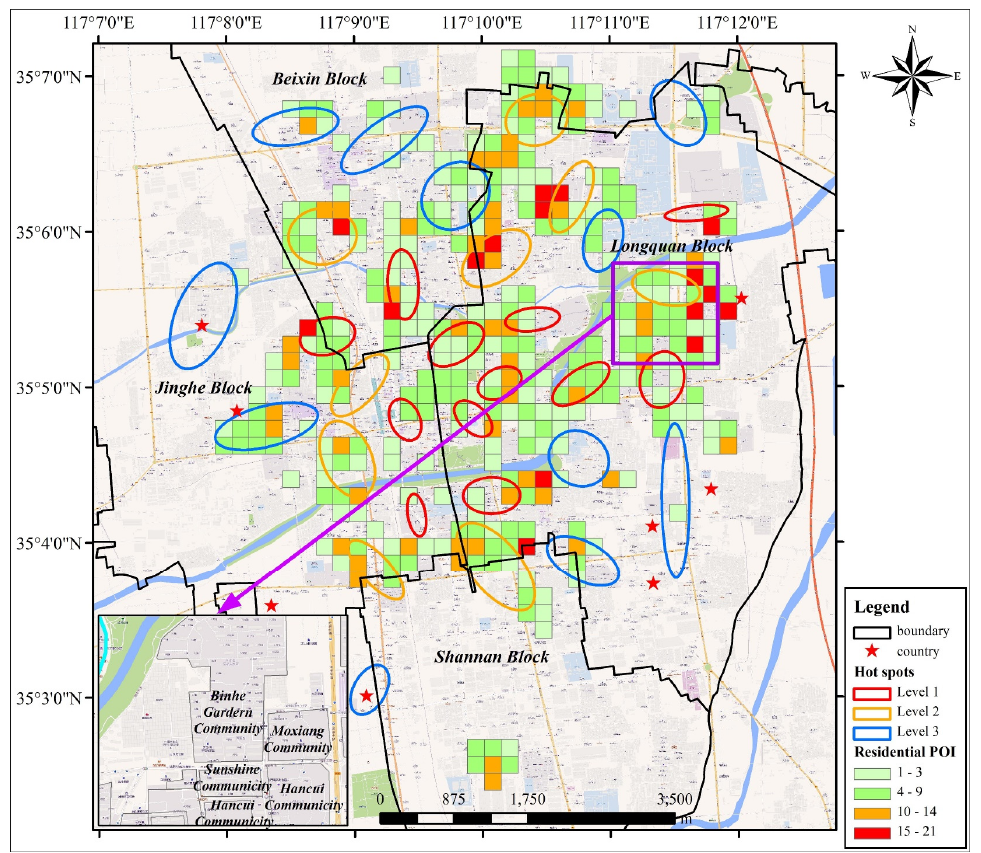
Figure 6. Distribution of the points of interest (POIs) data and hot spots at different levels.